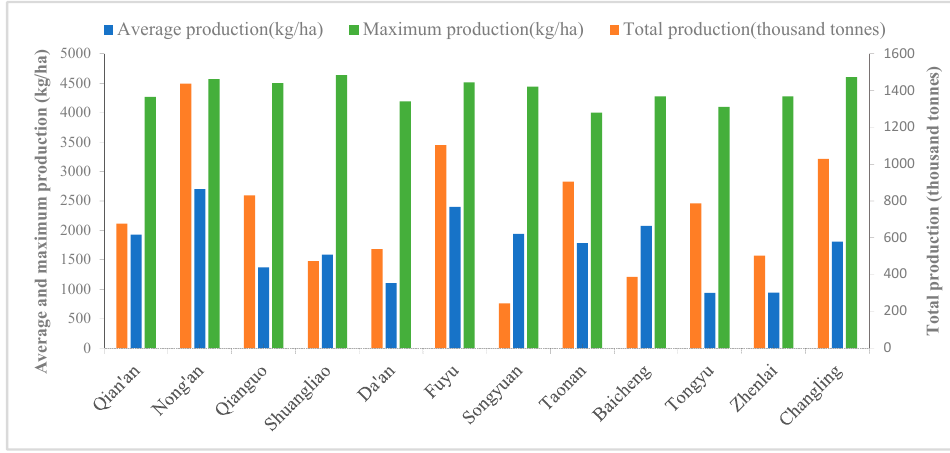
Figure 5. Soybean production potential in Western Jilin in 2013.